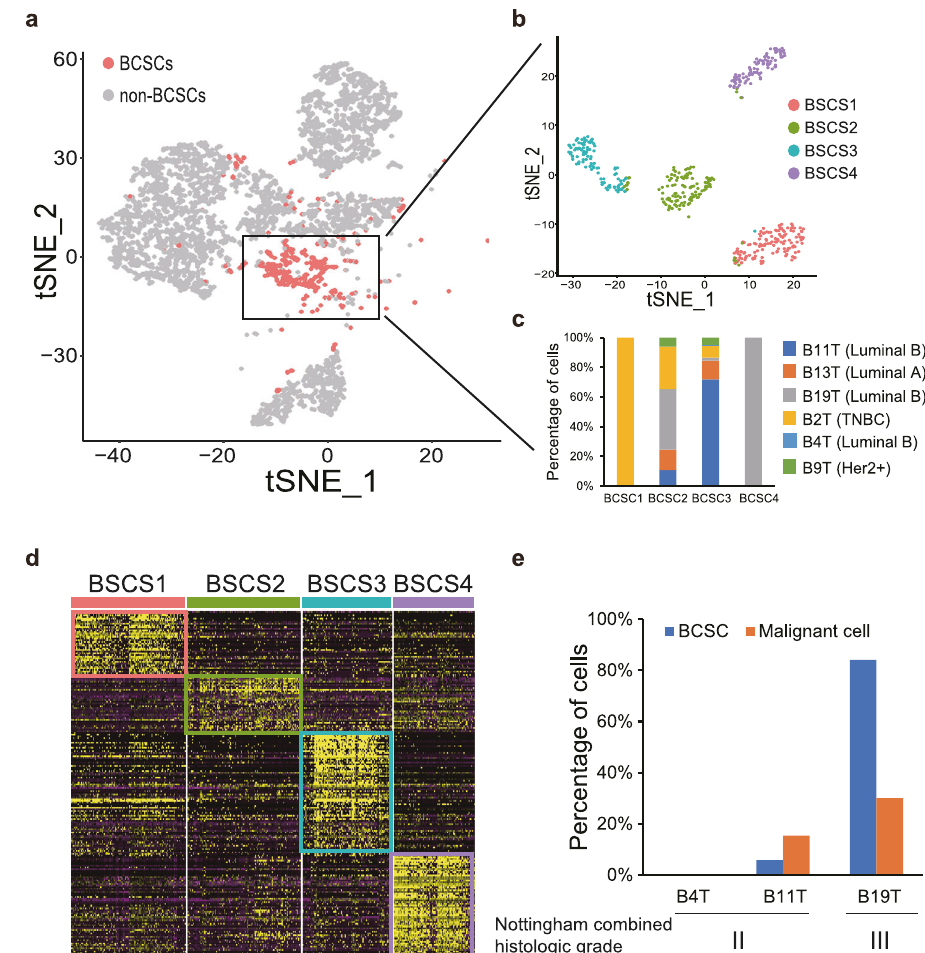
Fig. 6 The heterogeneity of stem-like cells in breast cancer patient tumors. a The t-SNE plot highlighted the distribution of cancer stem cells from breast cancer patients. Cancer stem cells were highlighted in color and normal cancer cells were in gray. b Re-clustering of cancer stem cells by Seurat. c Histogram showed the composition of cancer stem cells from each patient. d Heatmap demonstrated the genes speci fi cally expressed in each BCSC cluster. e Histogram showed the percentage of BCSCs and malignant cells in each